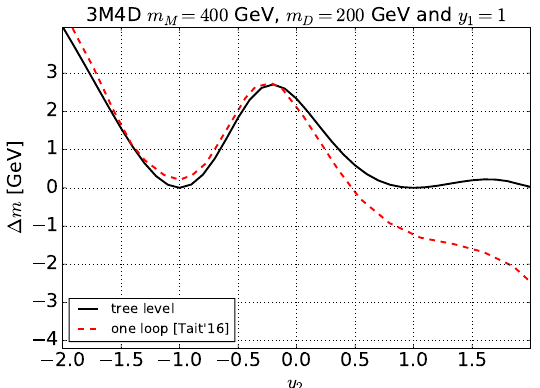
Figure 6. Mass splitting (cid:1) m = m function of y 2 for m M & m (cid:3) . The continuous black curve is the mass splitting at tree level. The red dashed curved is that at one-loop as obtained in ref.